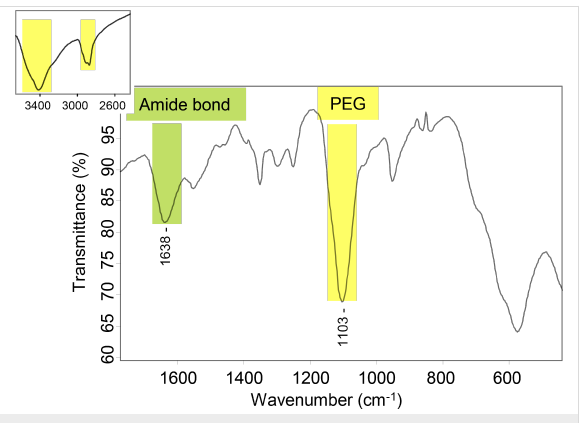
Figure 5: FTIR spectrum of USM-PEG nanoparticles. Highlighted signals are discussed in the